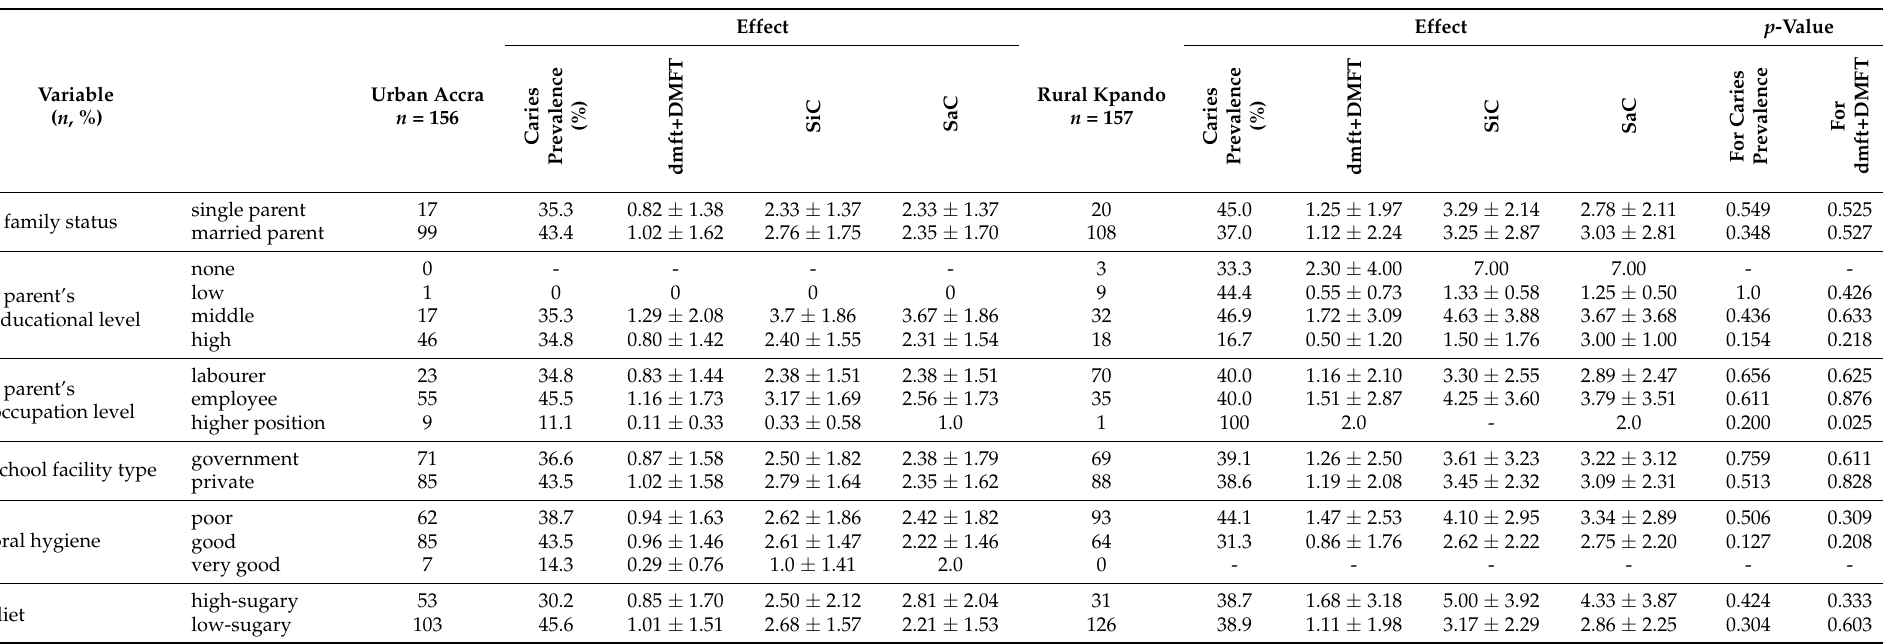
Table 3. Outcomes in caries prevalence and caries experience (mean dmft+DMFT, SiC, and SaC) depending on family status, parent’s educational level, parent’s occupation level, and school facility type attended by the study participant, oral hygiene, and